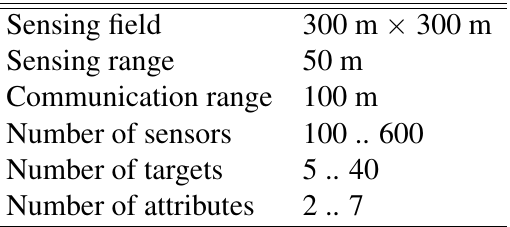
Table 2. Simulation setting for MU-CTC